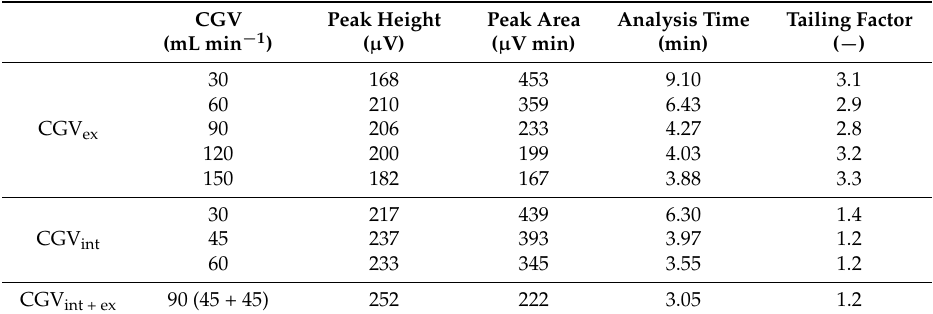
Table 3. Peak parameters for different volumetric flow rates of the carrier